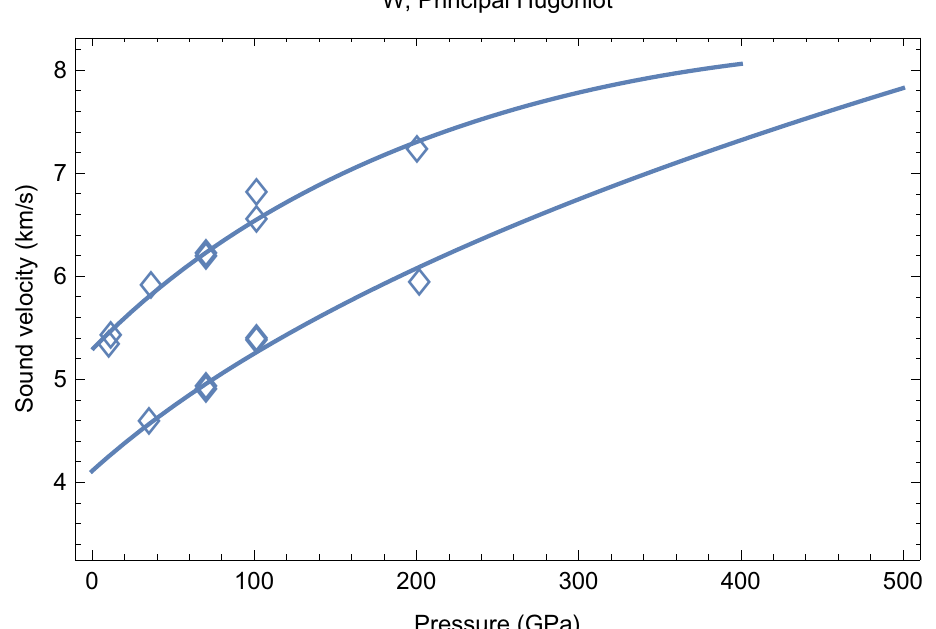
Figure A4. Longitudinal (upper) and bulk (lower) sound velocities in bcc-W along its principal Hugoniot: comparison of the unified analytic melt-shear model (curves) to the experimental data of Reference [61]